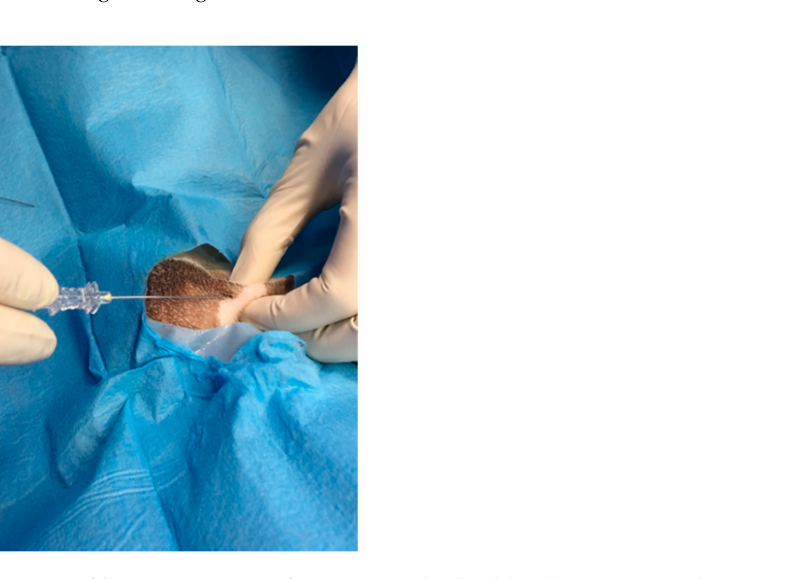
Figure 3. The ultrasound-guided peripheral nerve block by injection of a solution containing 0.5% concentrated ropivacaine hydrochloride into the spermatic cord at the level of its emergence from the superficial inguinal ring.